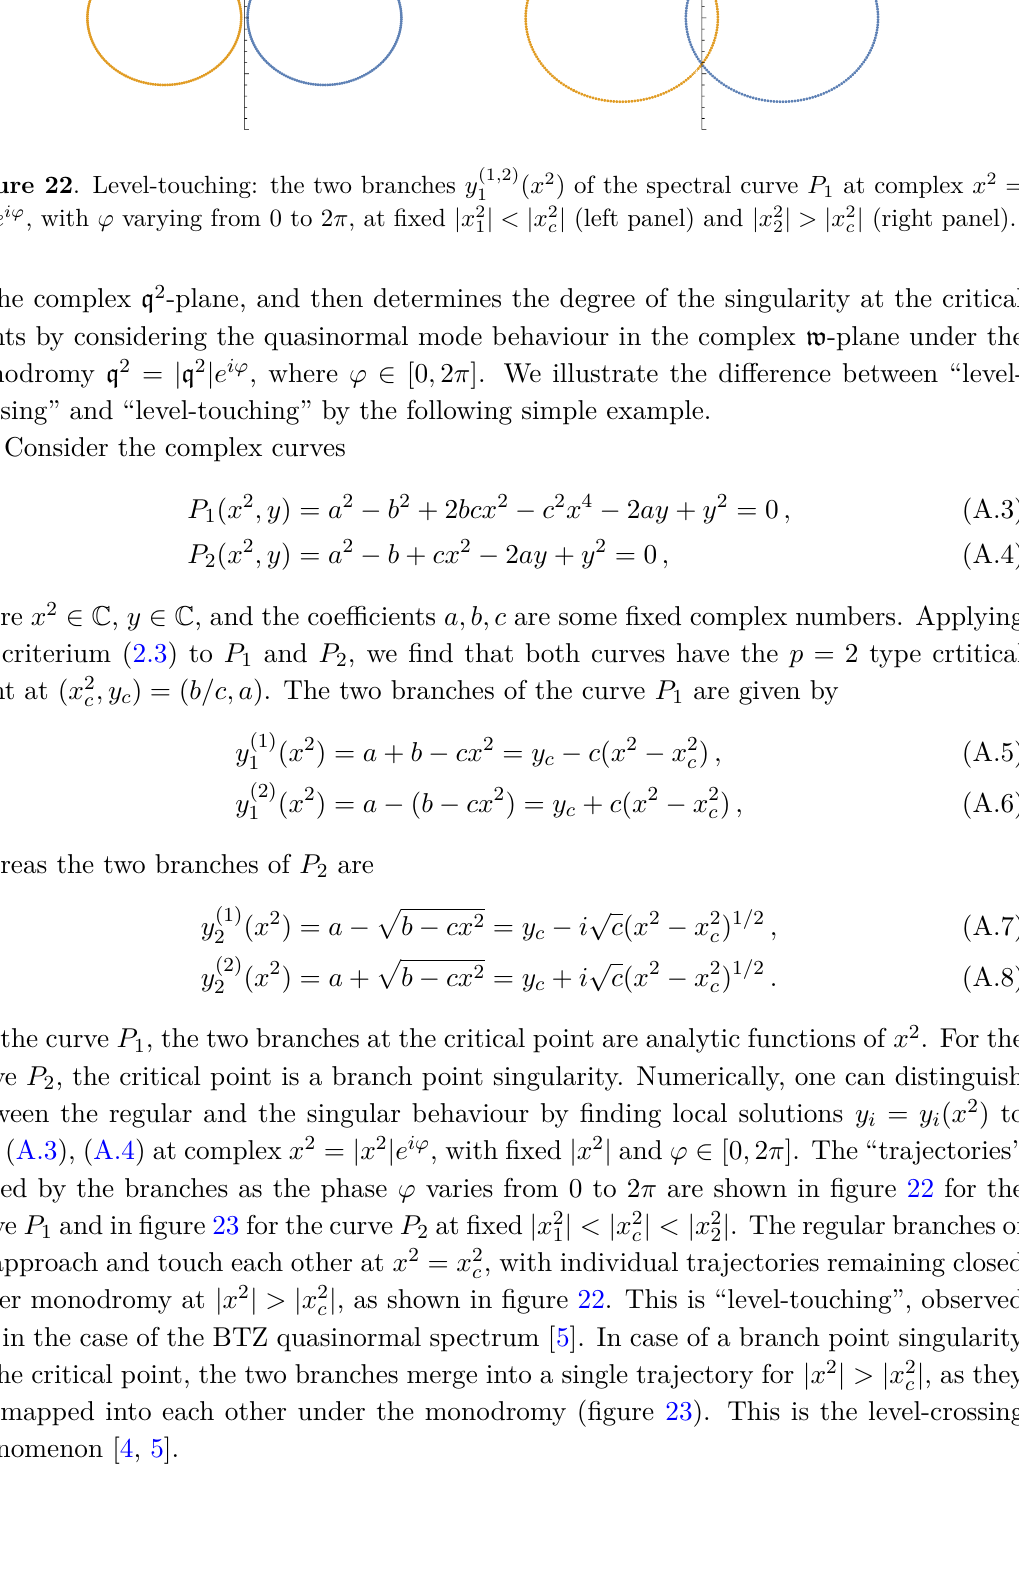
Figure 22 . Level-touching: the two branches y (1 , 2) | x 2 | e iϕ , with ϕ varying from 0 to 2 π , at fixed | x 2